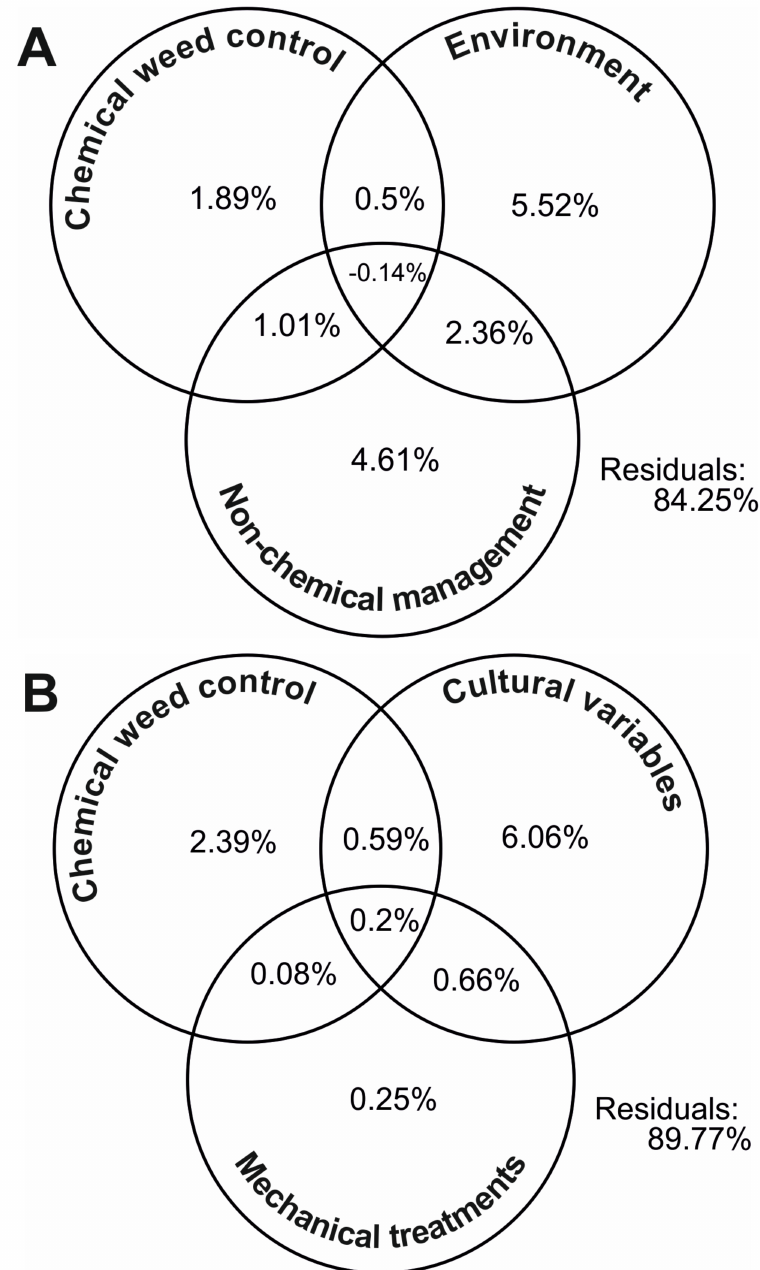
Figure 5. Percentage contributions of groups of significant explanatory variables to the variation in weed species composition, identified via variation partitioning in the broad-scale survey (BS). ( A ): Environmental vs. non-chemical management vs. chemical weed control variables; ( B ): cultural vs. mechanical vs. chemical components of weed management (environment variables are among the residuals